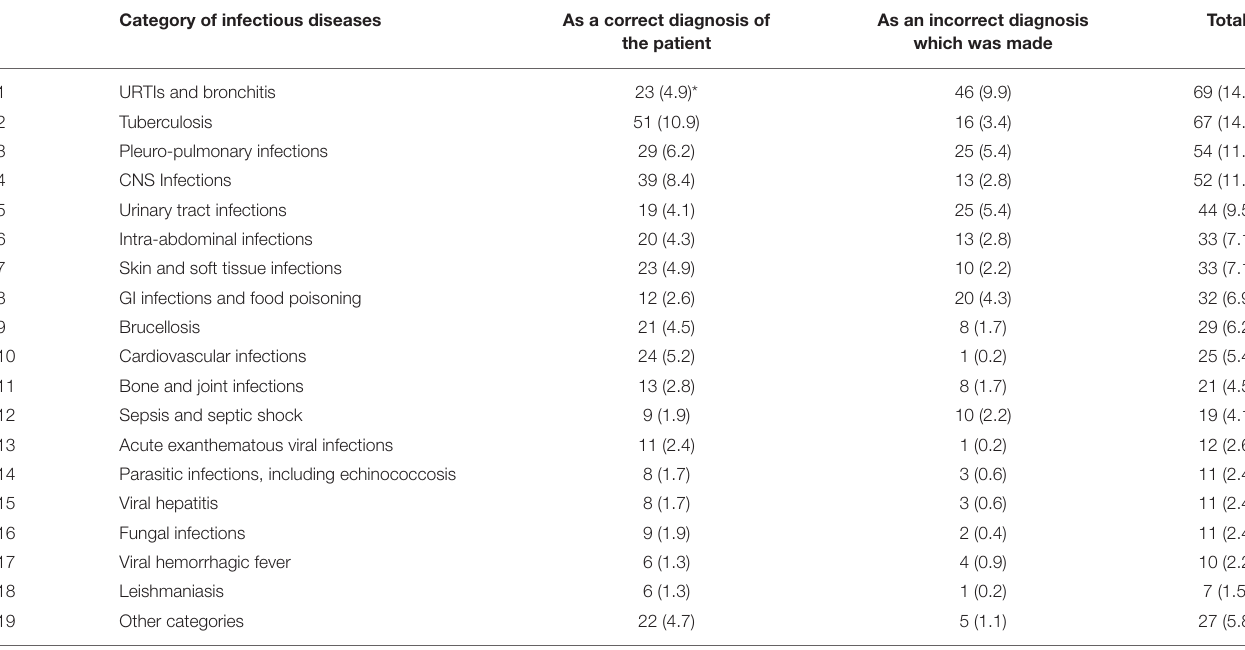
TABLE 2 | Infectious diseases affected by diagnostic errors according to the physician reports in order of frequency. Category of infectious diseases As a correct diagnosis of the patient